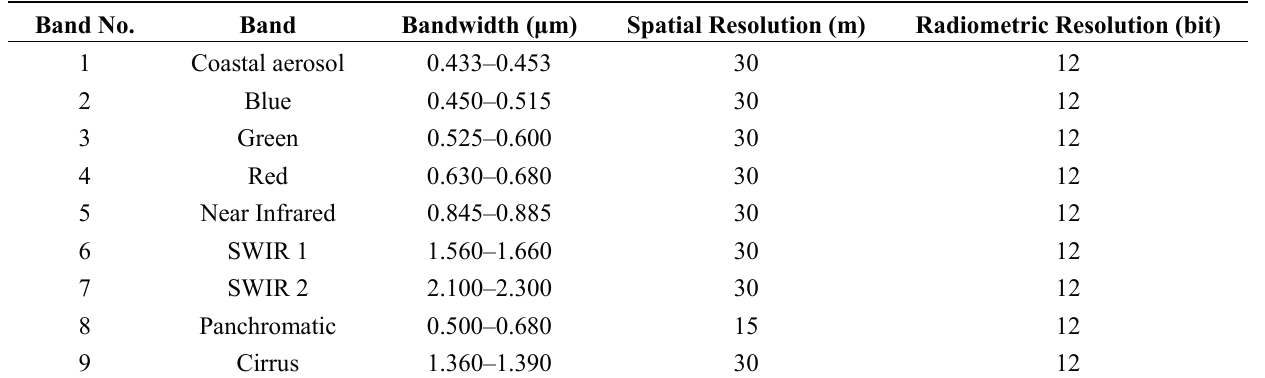
Table 1. Spectral bands of the Landsat 8 OLI.